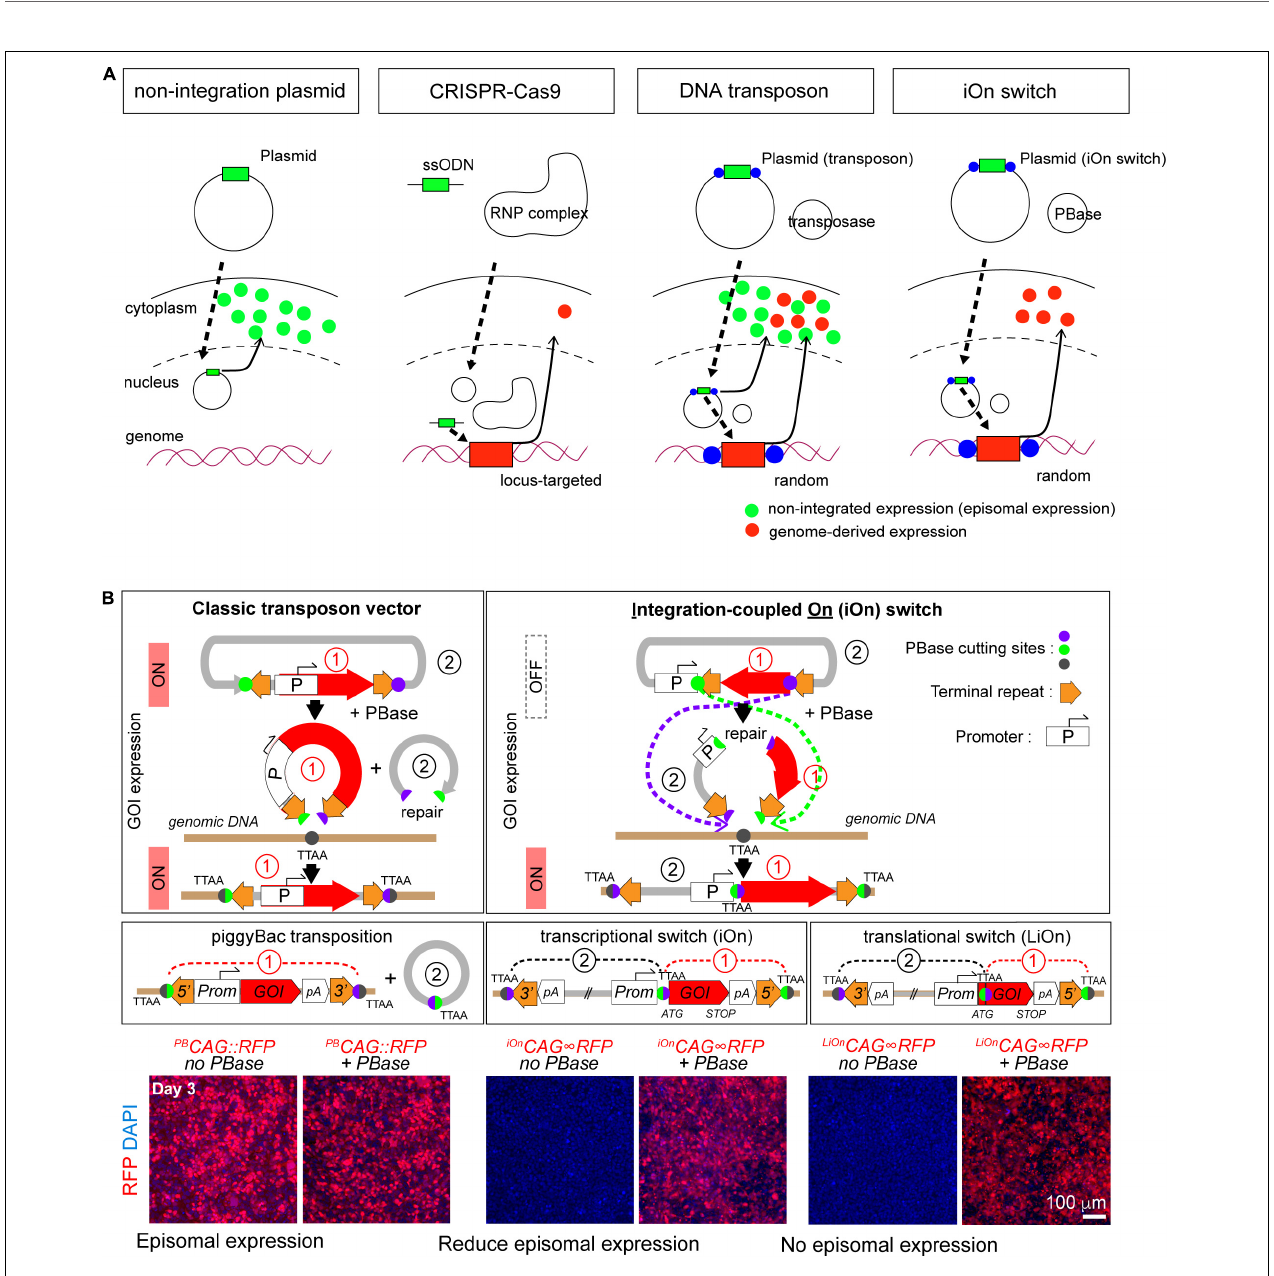
FIGURE 2 | Principle of the electroporation-based gene transfer tools. (A) Comparison of the gene transfer mechanisms. (B) Principle of gene transfer with classic transposon (left) and iOn switch (right). GOI: gene of interest. Images used from Kumamoto et al. (2020), Neuron according to